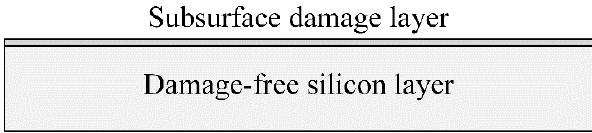
Figure 2. Two layers of the silicon wafer in the finite element model.